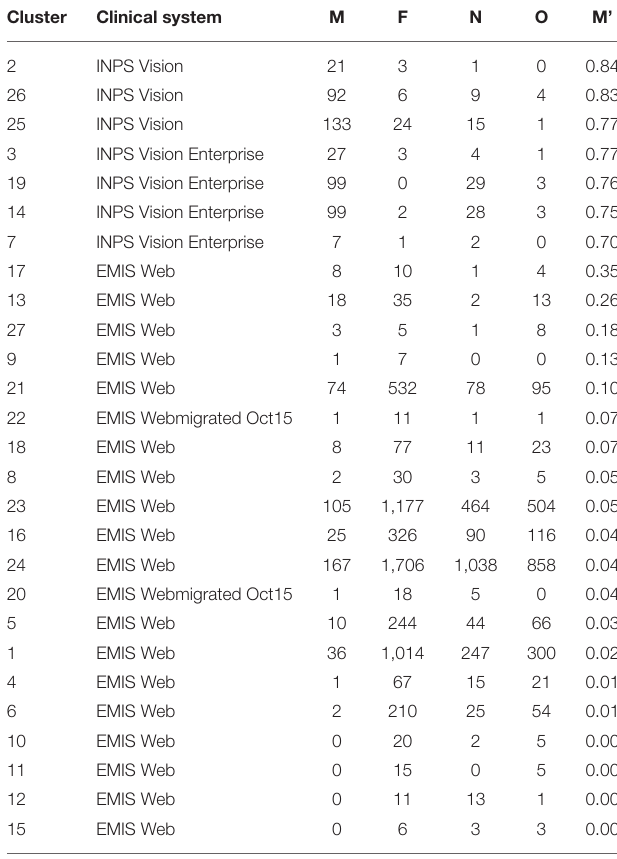
TABLE 2 | Rank clusters by highest proportion of missing Episode